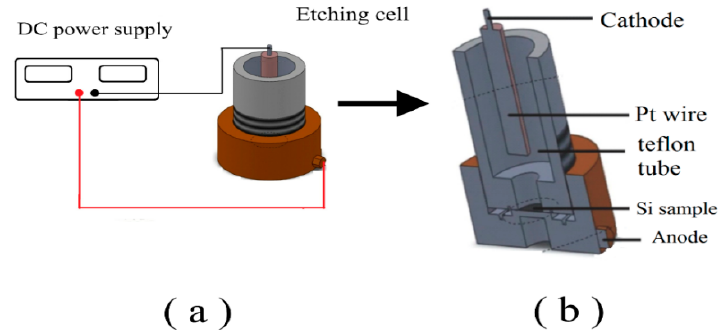
Figure 1. Experimental setup for PSi ( a ) and cross section of the etching cell ( b ).